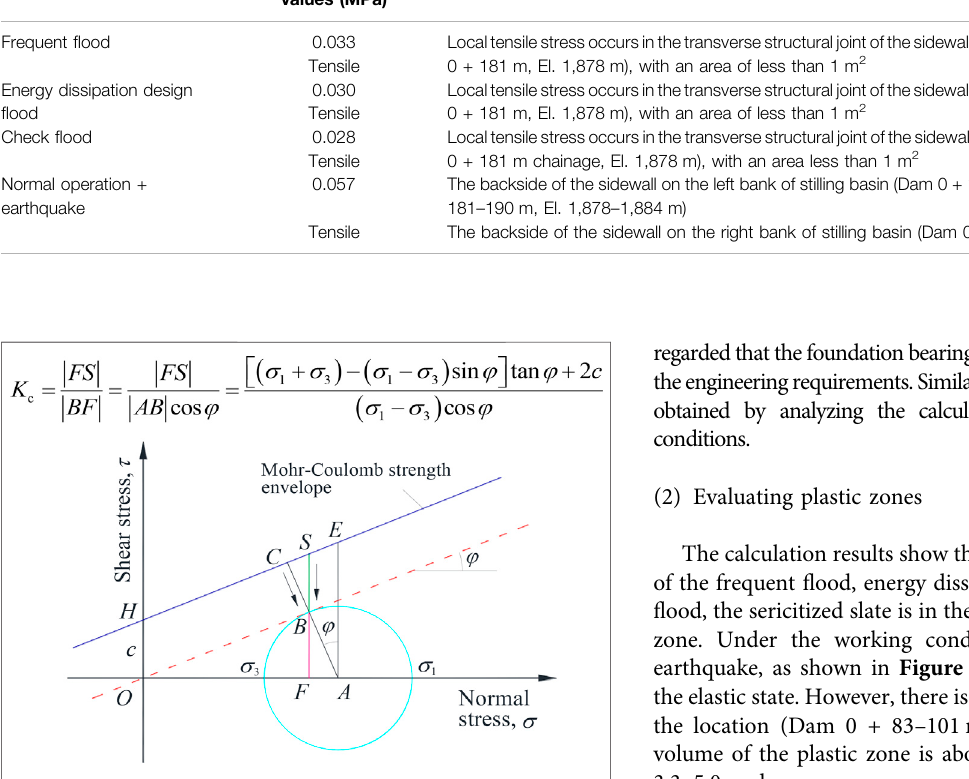
FIGURE 8 | De fi nition of stress state at a point, Mohr-Coulomb strength line and point safety factor.